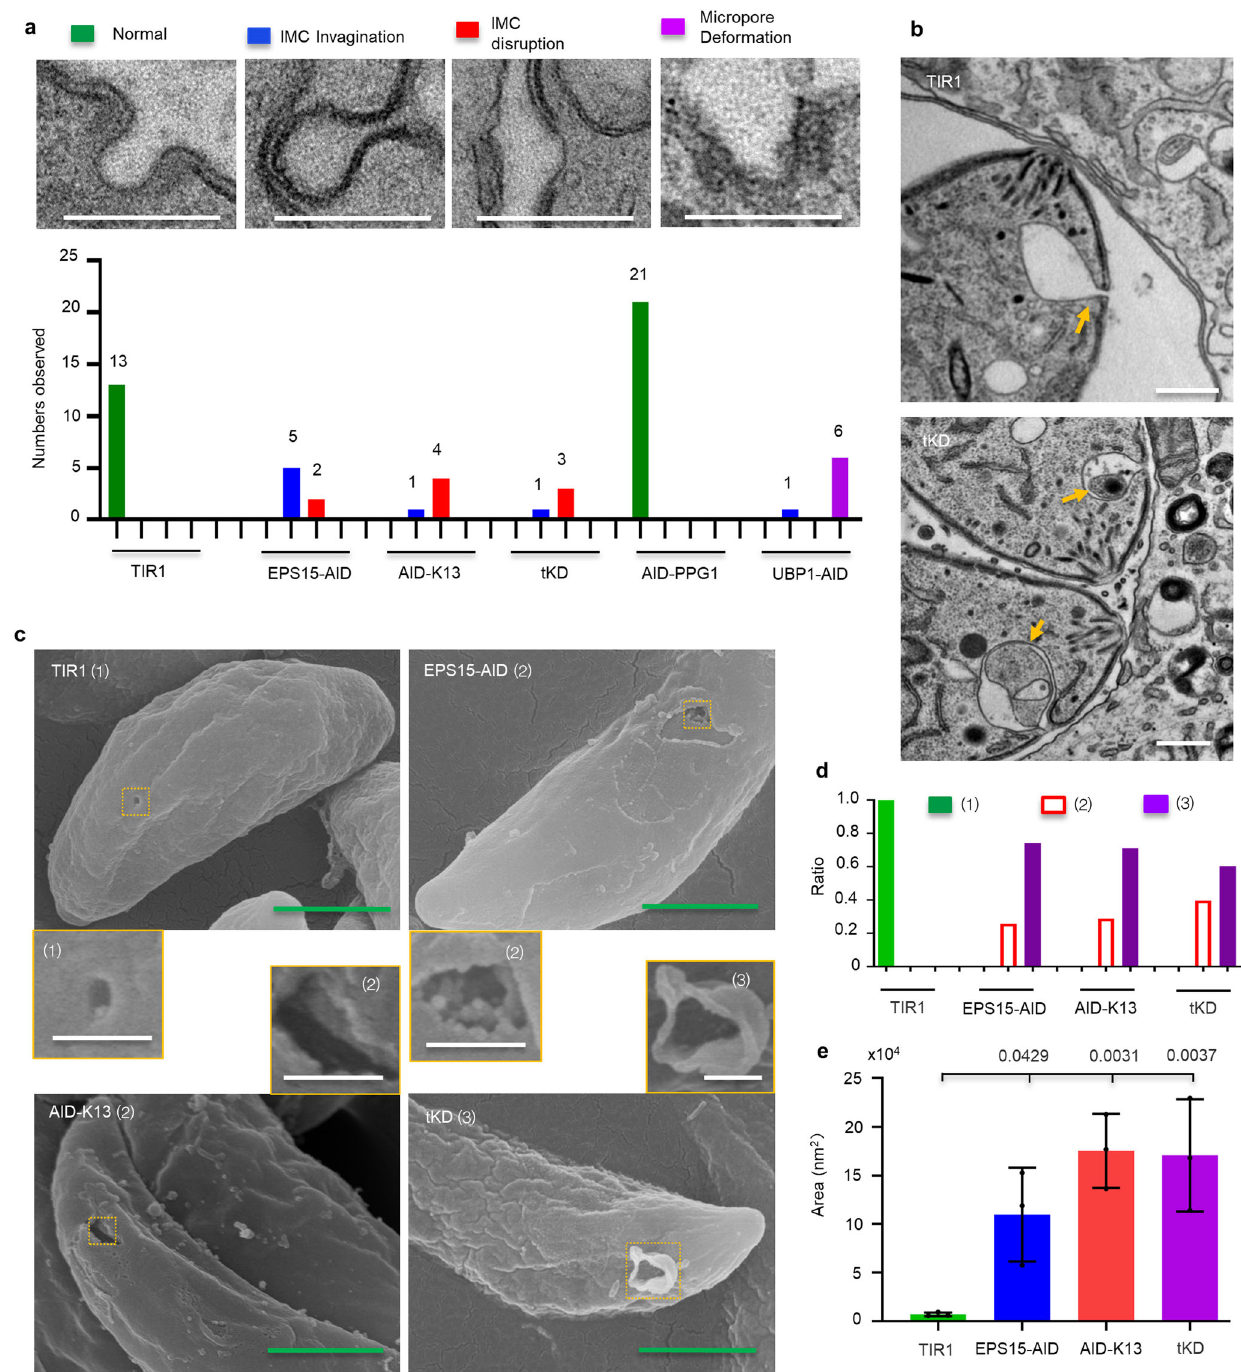
Fig.6|TheKelch13complexaffectstheintegrityofthemicropore.a Micropore structures on TEM and its quanti fi cations. Serial TEM was performed to examine different types of micropore defects in the parasite lines grown in auxin for 30h. These defects were quanti fi ed by TEM for 600 parasites from each line. The micropore defects were indicated by colors, which relate to the graphs. Scale= 200nm. b Plasmamembrane invagination closeto the apexwasobserved onTEM analysis in IAA induced parasites for 30h, as in a . This invagination (yellow arrowhead) was previously shown in parasites treated with 200 µ m oleic acid 60 . Here it shows the tKD and TIR1 grown in auxin. Scale=500nm. c , d Scanning microscopyobservation ofthe corrupted microporein parasiteswith IAAfor 30h.